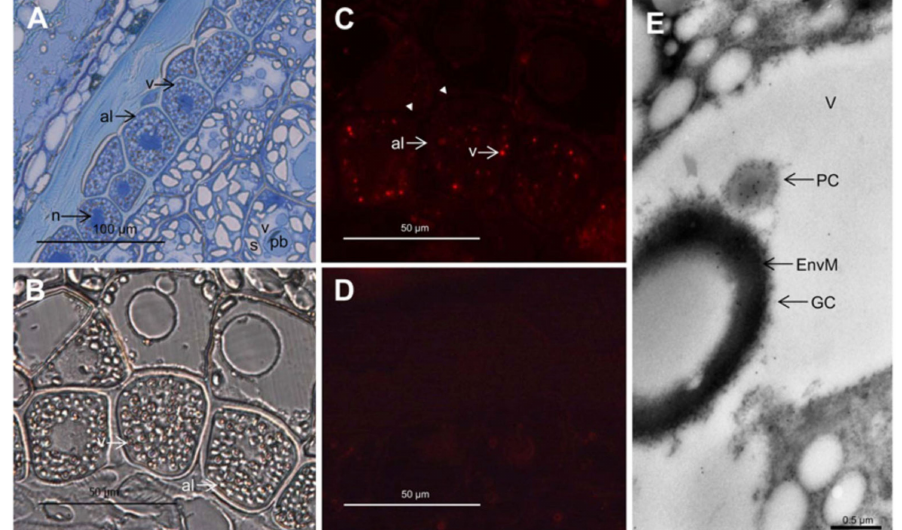
Figure 2. Light ( A – D ) and immunoelectron ( E ) microscopy analysis of the localization of PAPhy in the developing wheat grain, approximately 18 days post anthesis. ( A ) Toluidine blue-stained semithin cross-section of endosperm, aleurone, and pericarp tissues. ( B ) Di ff erential interference contrast microscopy with indications of the PSVs. ( C ) Immunofluorescence detection of PAPhy in 1 µ m thick sections. The aleurone vacuoles are clearly labeled, while there is no fluorescence from any other compartment of the cell, the apoplast (arrowheads), or other cell types. ( D ) Immunofluorescence of a 1 µ m thick section incubated with secondary antibody only. There is virtually no background from the secondary antibody. ( E ) Immunoelectron microscopy analysis showing an aleurone PSV with gold labeling of the protein crystalloid. al, Aleurone; EnvM, globoid enveloping membrane; GC, globoid crystal; n, nucleus; pb, protein body; PC, protein crystalloid; s, starch; v, vacuole. Reprinted in part from [25]. Copyright: American Society of Plant Biologists; http: //